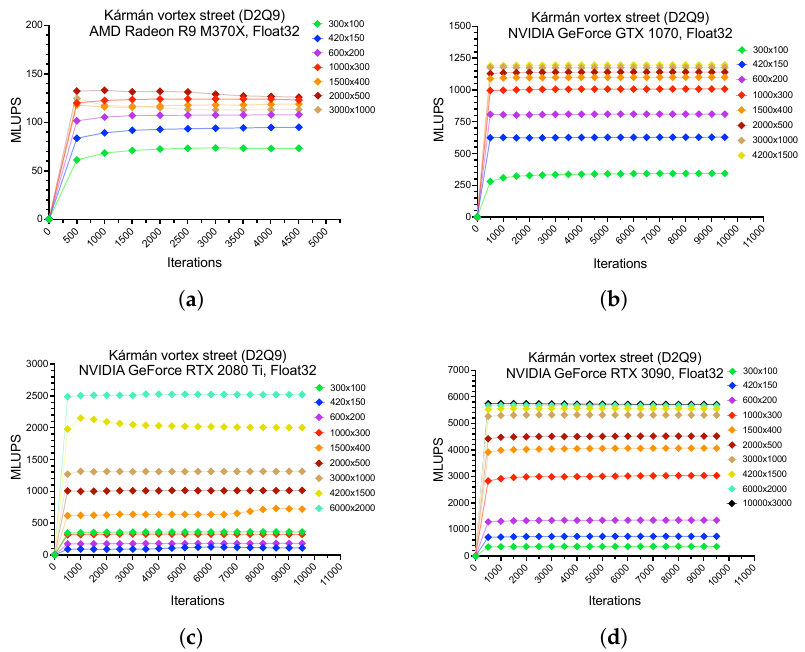
Figure 7. Single-precision performance analysis of 2D Kármán vortex on D2Q9 stencil. ( a ) Perfor- mance on Radeon R9 M370X GPU; ( b ) Performance on GTX 1070 GPU; ( c ) Performance on RTX 2080 Ti GPU; ( d ) Performance on RTX 3090 GPU.